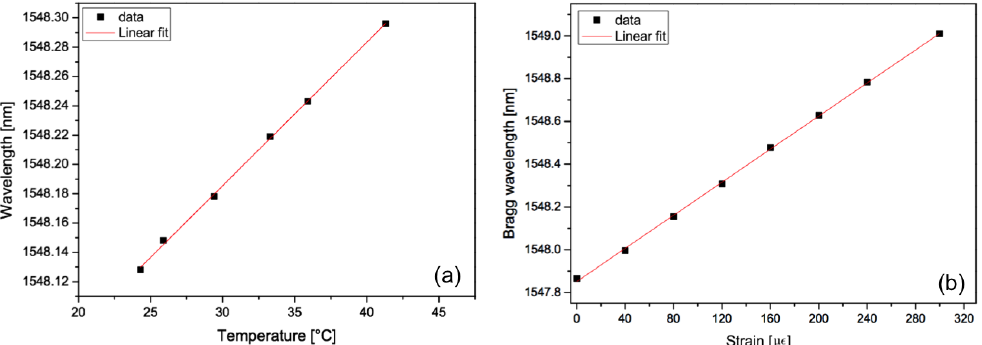
Figure 2. Bragg wavelength shift as a function of a temperature change ( a ) and a mechanical axial strain ( b